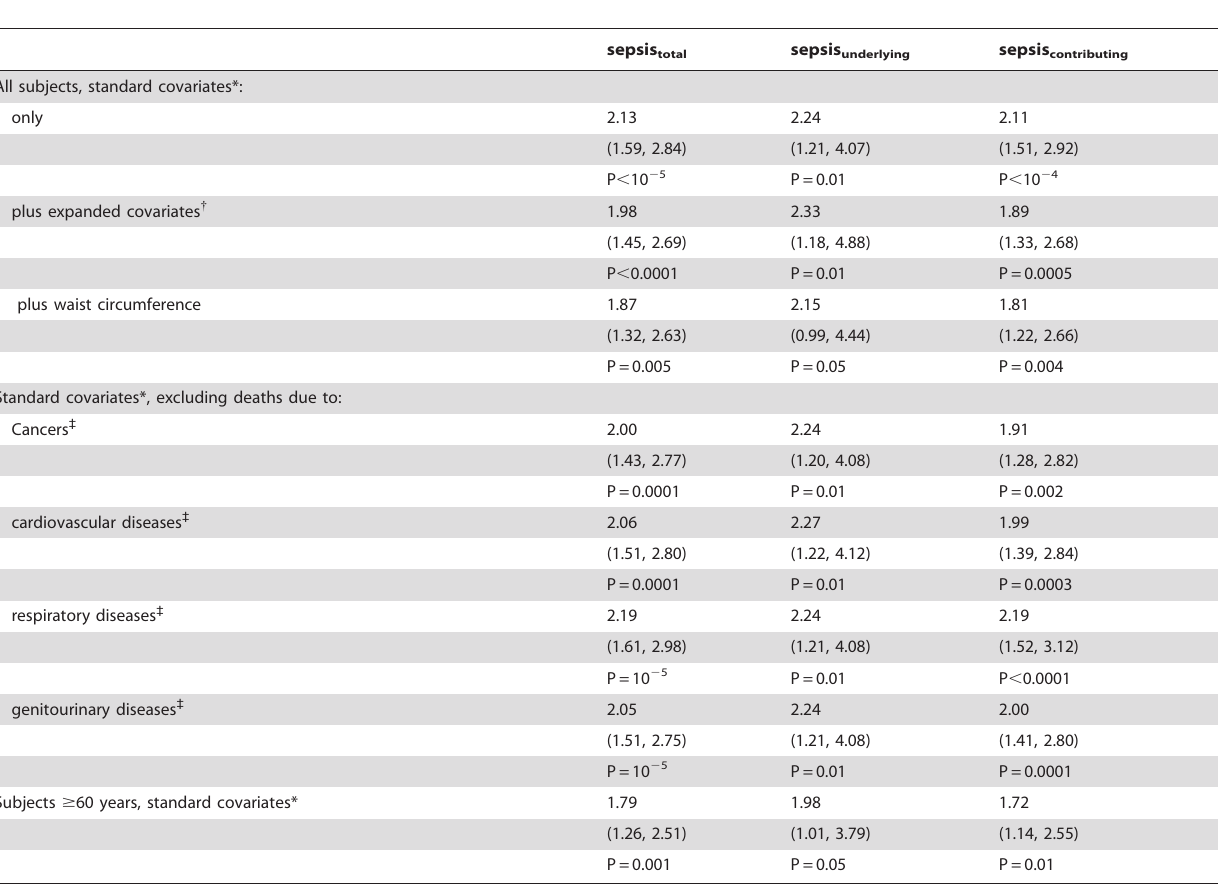
Table 2. Hazard ratios from Cox proportional hazard analyses (95% confidence interval) of sepsis mortality for inadequate exercise vs. achieving or exceeding the exercise recommendations, i.e., , 1.07 MET-hours/d vs. $ 1.07